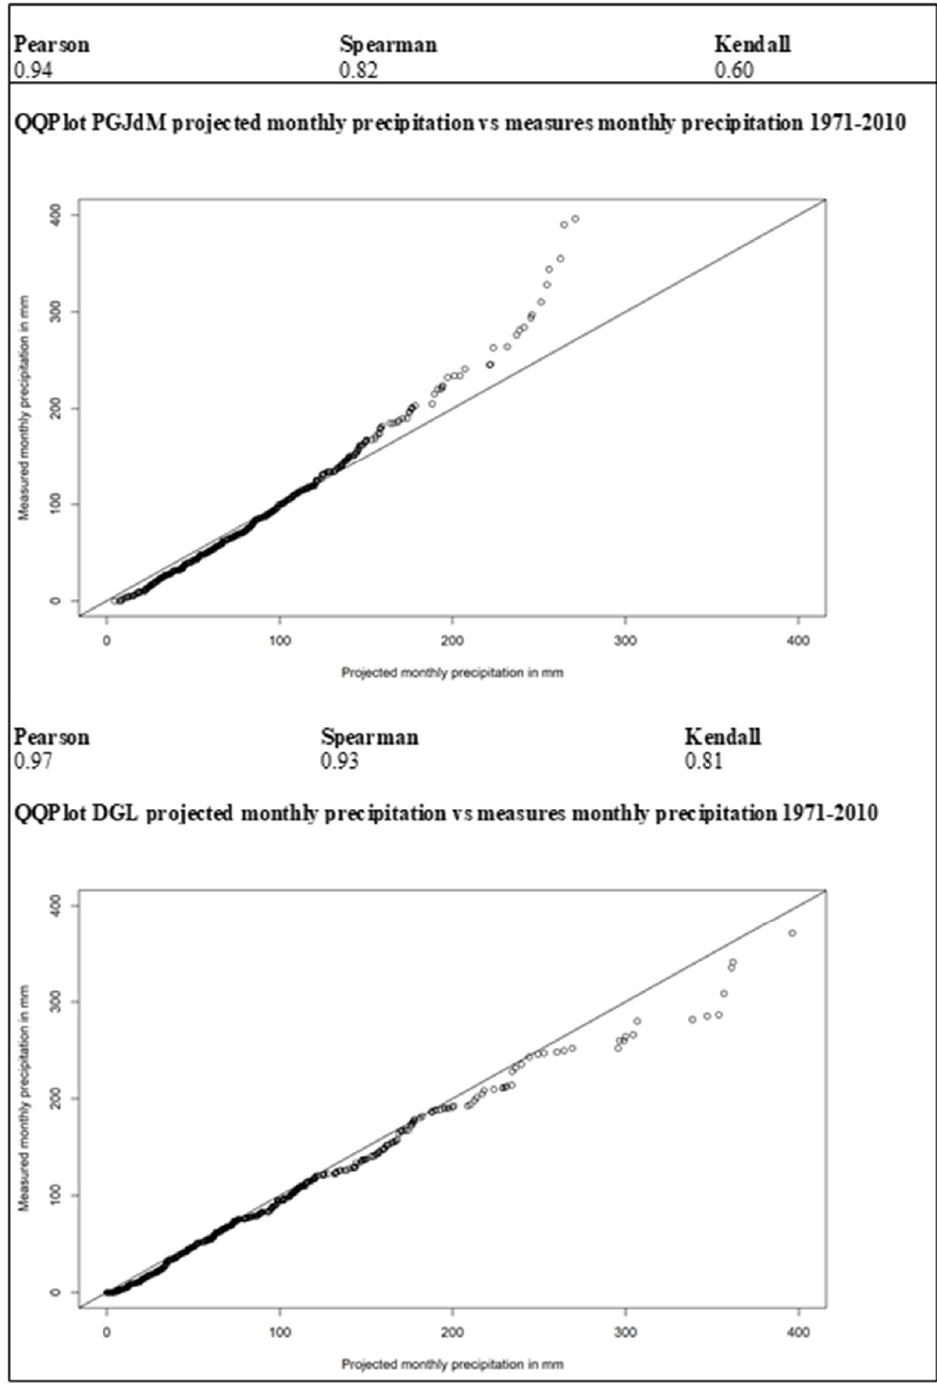
Figure A2. Comparison of sorted monthly precipitation in the PGJdM (top) and the DGL (bottom): historical vs. modelled (1971–2010).